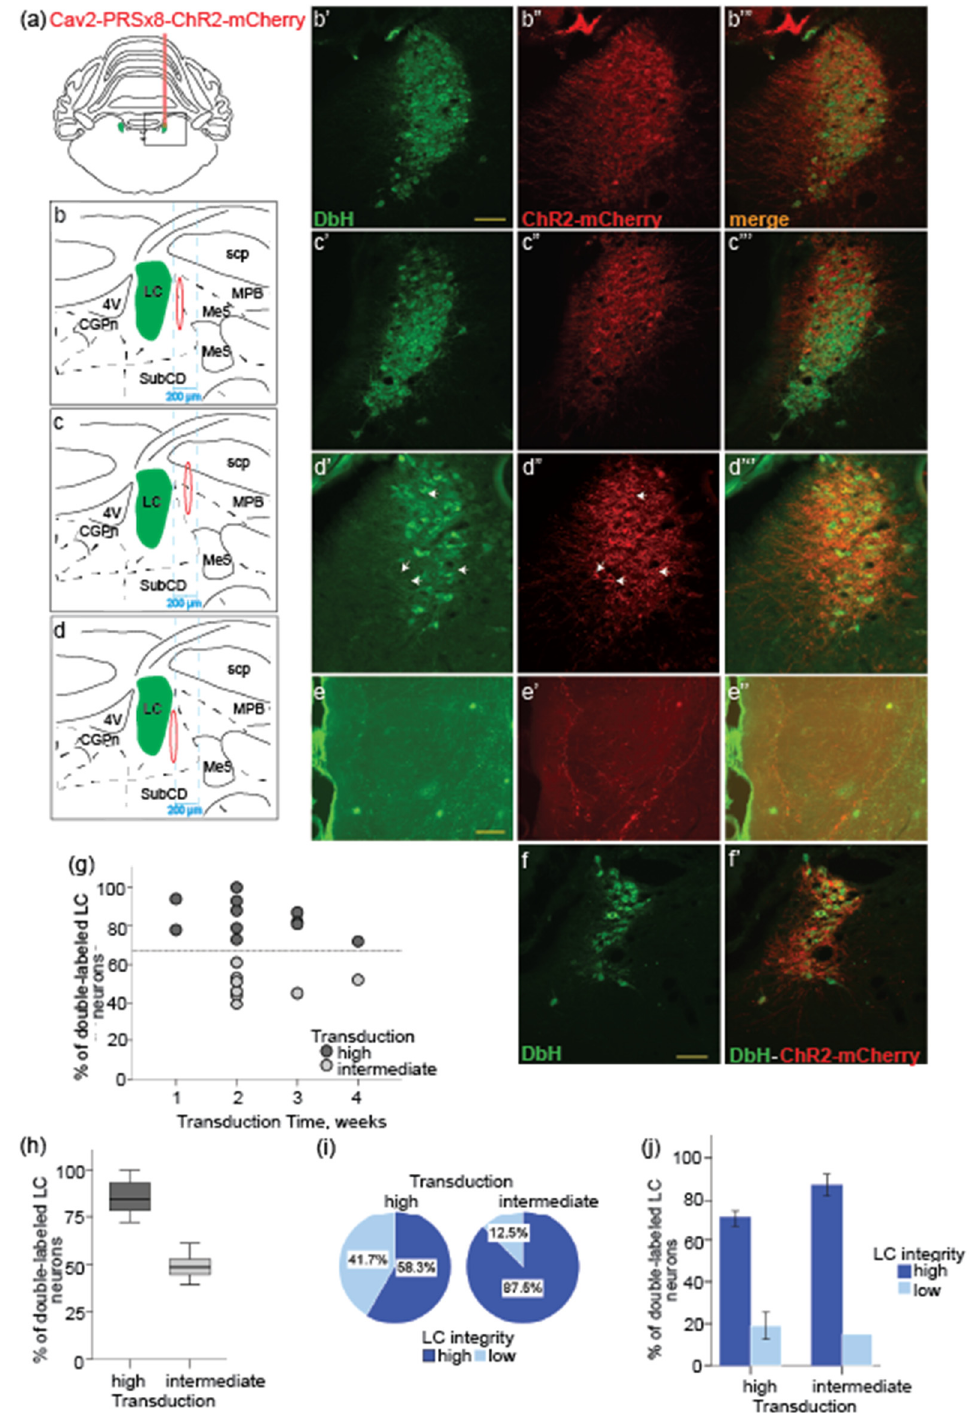
Figure 2. Histological analysis of the efficiency of the CAV2-PRSx8-ChR2-mCherry viral vector for transduction of LC-NE neurons and their forebrain terminal fields: Reconstruction of the injection sites ( a – d ) and the coronal sections at the LC plane stained with DbH ( b’ – d’ , green), mCherry ( b” – d” , red), and an overlay ( b”’ – d”’ , yellow). Representative examples with the high ( b’ – b”’ ) and intermediate ( c’ – c”’ ) virus transduction in LC; ( d ) representative example with downregulation of DbH expression in LC neurons. Oval shapes show estimated virus spread; ( e ) DbH-stained LC ax- onal terminals in the PFC. ( f , f’ ) representative example of direct virus injection into the LC core with severe cell loss. Scale bars ( b”’ – d”’ , e – e” , f – f’ ): 100 μ m; (( g ) proportion of double-labeled LC neurons for each case ( n = 20) is plotted as a function of the virus transduction time. Regardless of the trans- duction time, there were cases with high (>70%) and intermediate (~50%) labeling; ( h ) The average